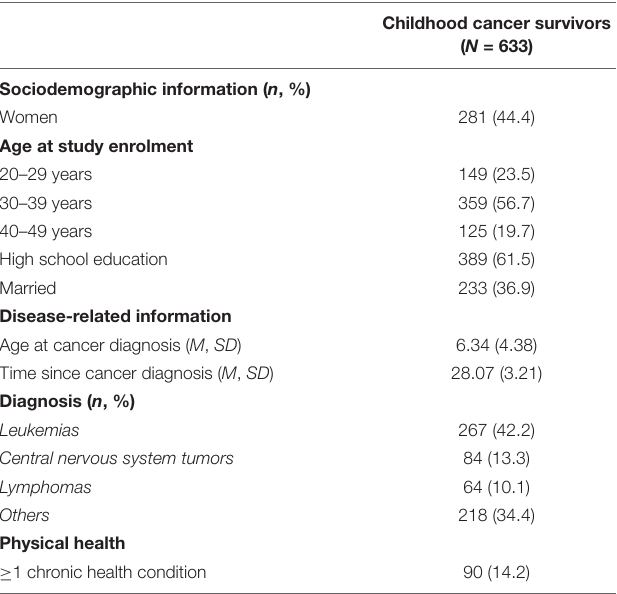
TABLE 1 | Participant characteristics.